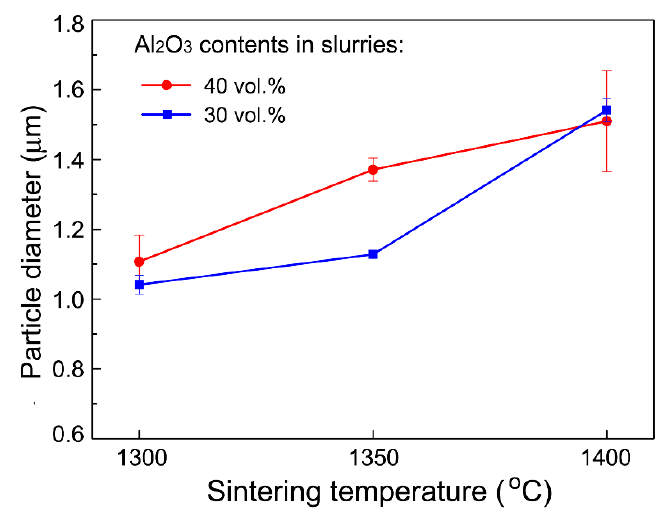
Figure 4. Variation of the particle diameter of porous Al 2 O 3 ceramics with sintering temperature.